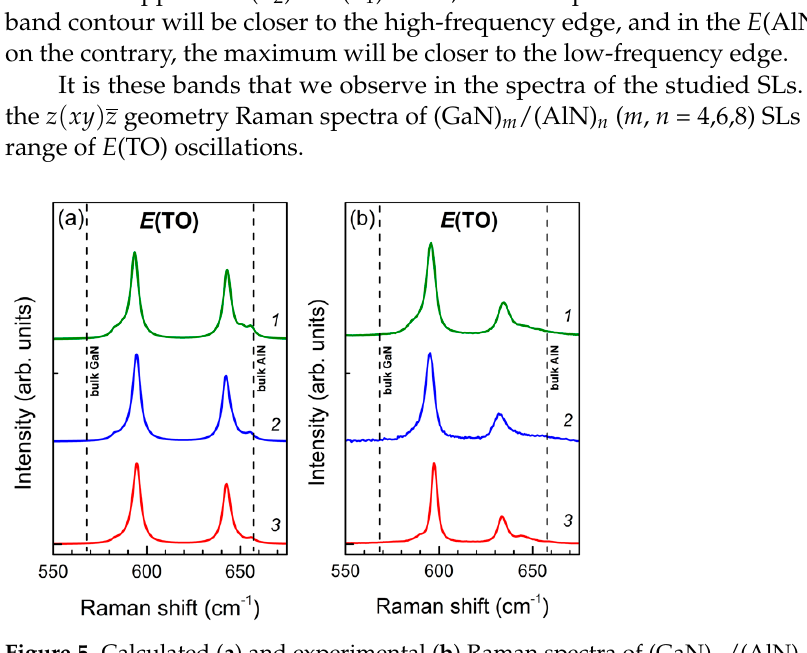
Figure 6. Raman frequencies and intensities of the E (TO) symmetry modes in the calculated spec ‐ trum of the 𝑧(cid:4666)𝑥𝑥(cid:4667)𝑧̅ geometry for the (GaN) 6 /(AlN) 6 SL. The solid black line shows the averaged spectrum for the Lorentzian line shape and the line half ‐ width of 3 cm − 1 . The blue line shows the experimental spectrum. It can be seen that six modes contribute to the profile of every band: modes 1–6 to the E (TO) ‐ GaN band and modes 7–12 to the E (TO) ‐ AlN band. The eigenvectors of the extreme ones are shown in Figure 7.